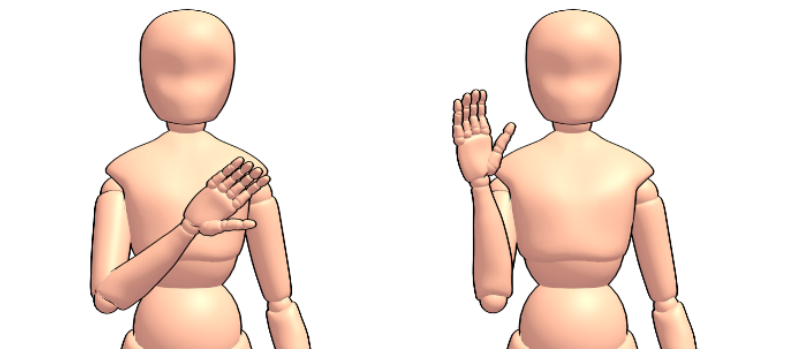
Figure 6. The sign for “Hello” in British Sign Language.